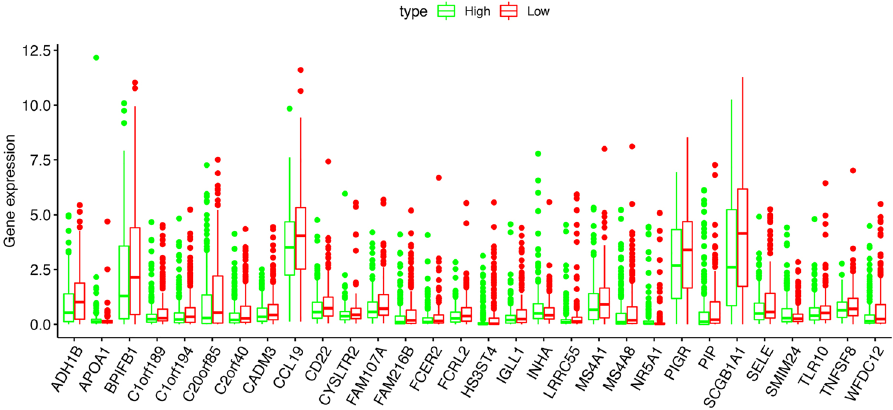
Figure 2. The expression of DEGs distributed in high-TMB and low-TMB groups.